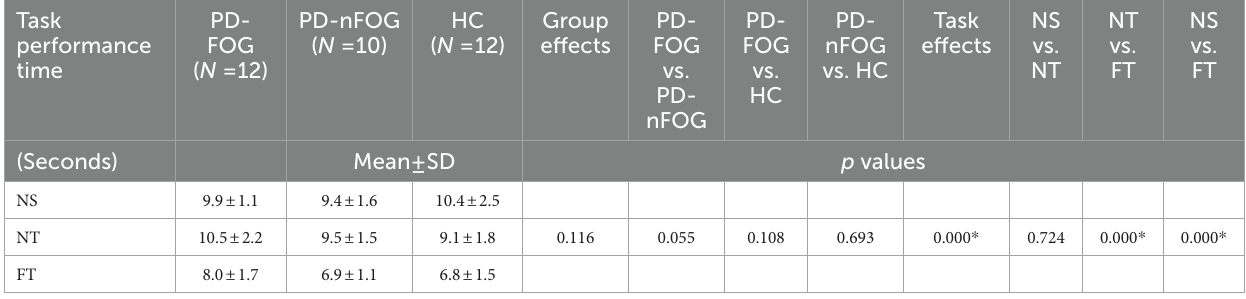
TABLE 3 Two-way ANOVA results of task performance time during different tasks among the PD-FOG, PD-nFOG, and HC